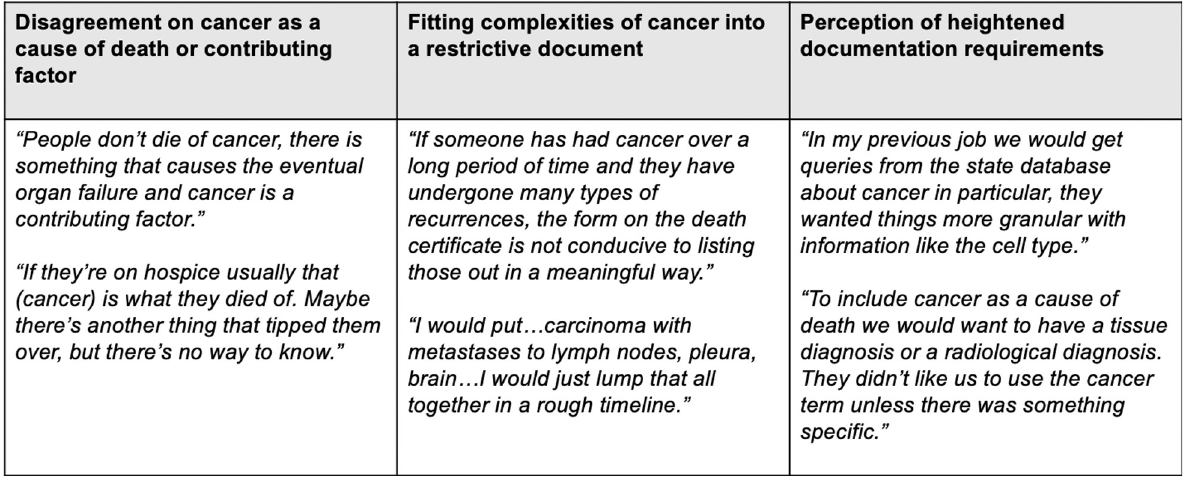
Fig 3. Challenges encountered when documenting cancer on the death